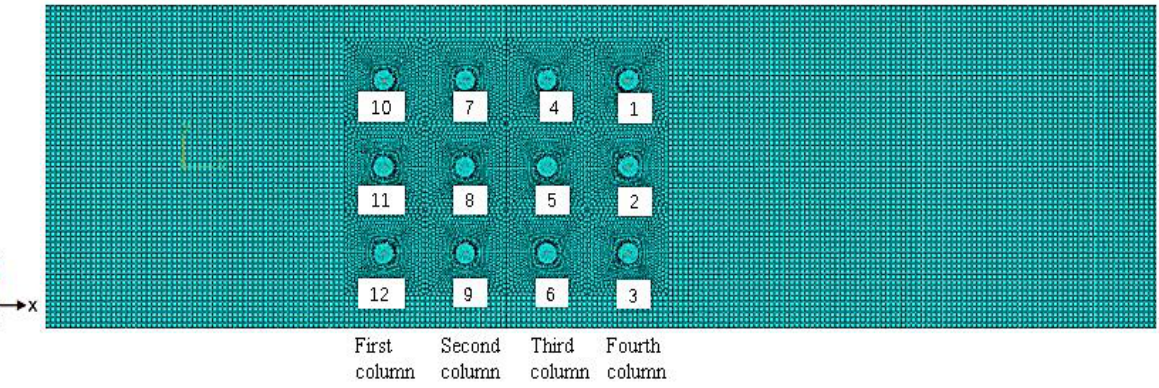
Figure 3. Schematic diagram of the evenly arranged rivet layout and mesh of strap butt joints.